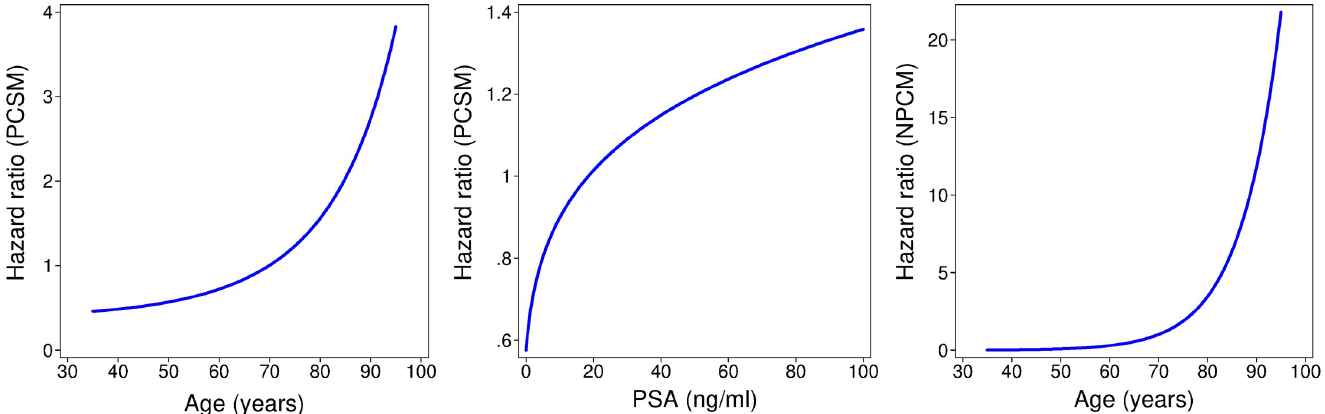
Fig 1. PCSM HR functions for age (left) and PSA (centre), and NPCM HR function for age (right). Each derived from the model development data. HR, hazard ratio; NPCM, non-PCa mortality; PCa, prostate cancer; PCSM, PCa-specific mortality; PSA, prostate-specific antigen.